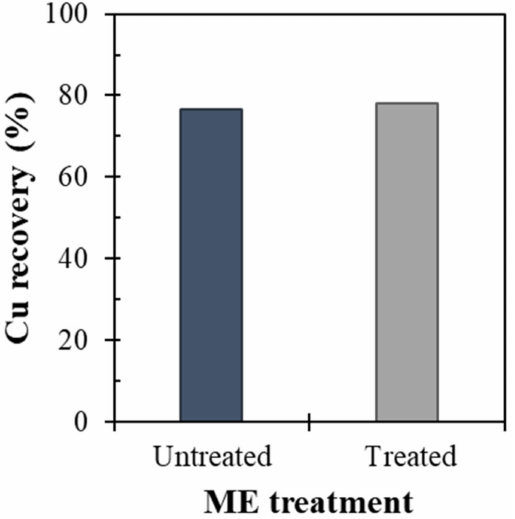
Figure 1. Effect of ME treatment on the floatability of chalcopyrite.